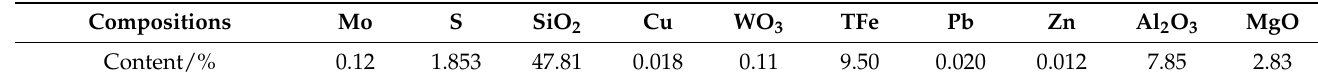
Table 1. The elements composition of the actual